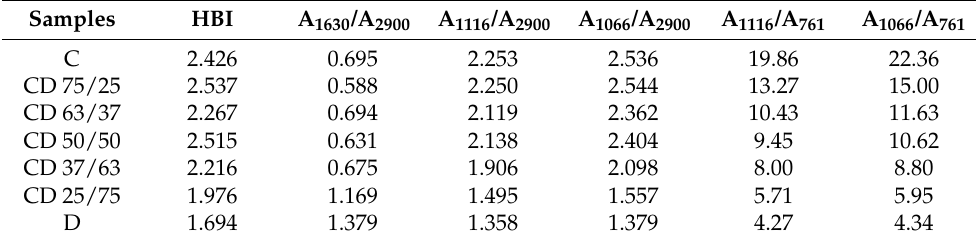
Table 4. ATR-FTIR spectral characteristics for cellulose (C), dextran (D) and CD hydrogels. Samples